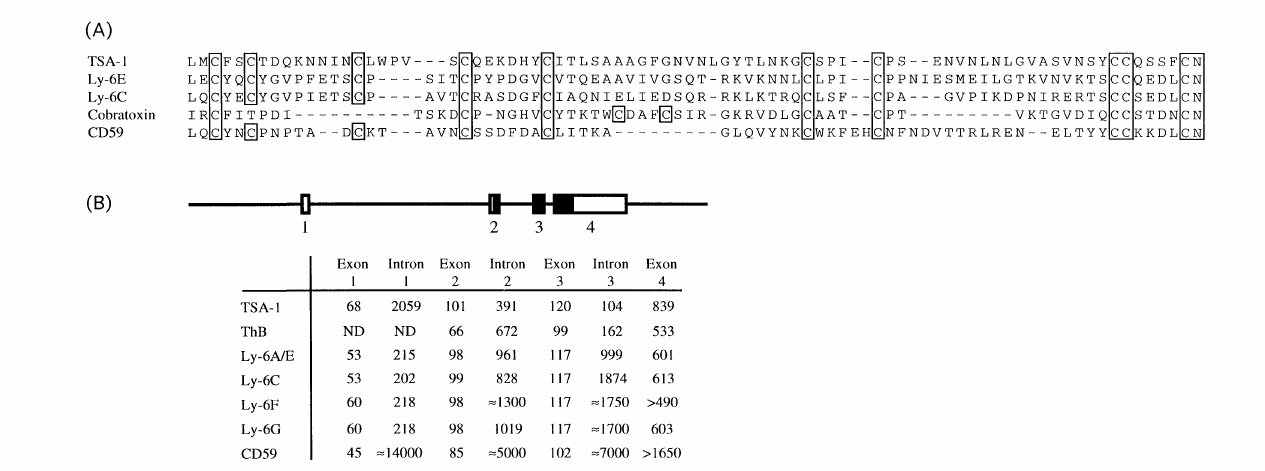
(A) Sequence homology between TSA-1 and the Ly-6SF. The sequence of TSA-1 is shown aligned with four other Ly-6SF molecules: Ly-6A (LeClair et al., 1986), Ly-6C (Palfree et al., 1988), CD59, and c-cobratoxin. (B) Gene structure of TSA-1. The intron/exon structure is drawn to scale for TSA-1 (Classon and Coverdale, 1996). The intron and exon sizes (in nucleotides) for single-domain Ly-6SF molecules whose gene sequences are known are indicated. The gene sequences were obtained from Ly-6A/E (Palfree et al., 1988); Ly-6C (Bothwell et al., 1988); ThB (Gumley et al., 1995b); Ly-6F and Ly-6G (Fleming et al., 1993); and CD59 (Petranka et al.,